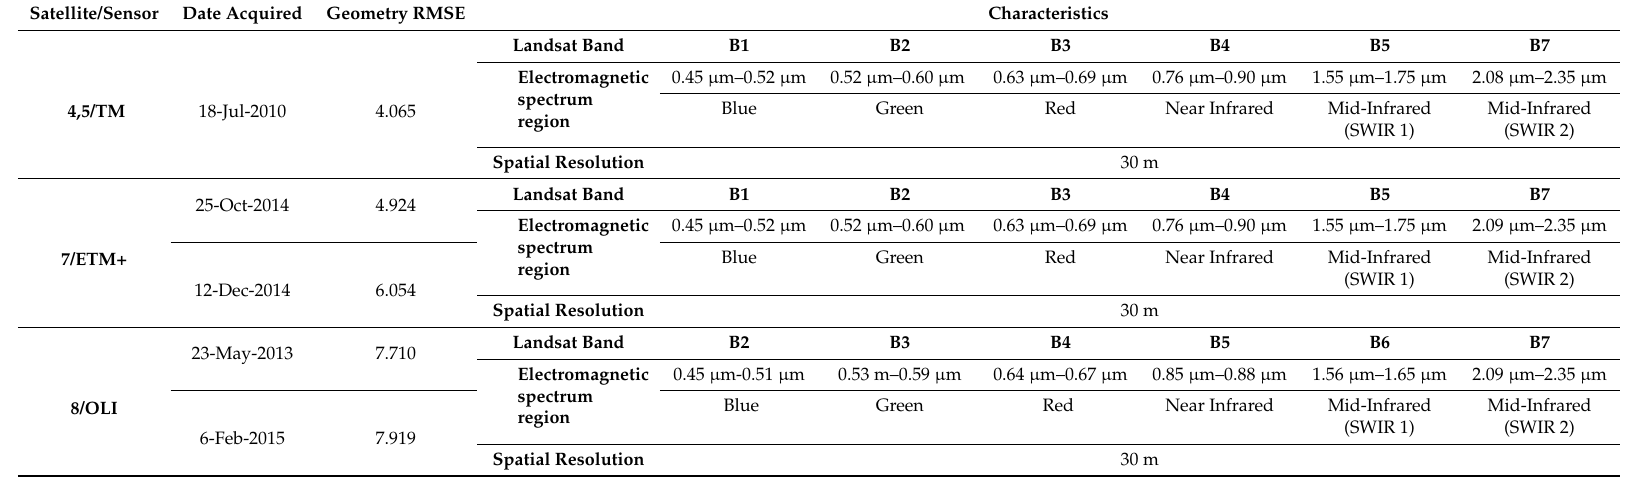
Table A1. Technical specifications of Landsat